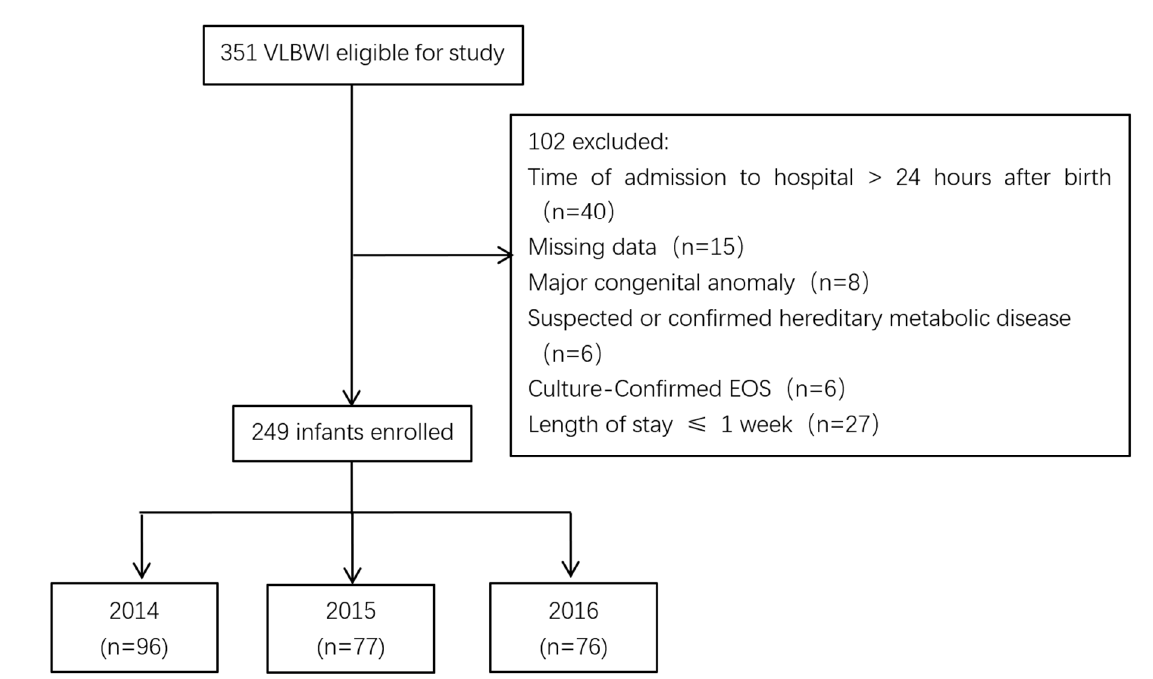
Figure 1. Flow diagram of the enrolled patients. Table 1. Baseline perinatal characteristics of the 3